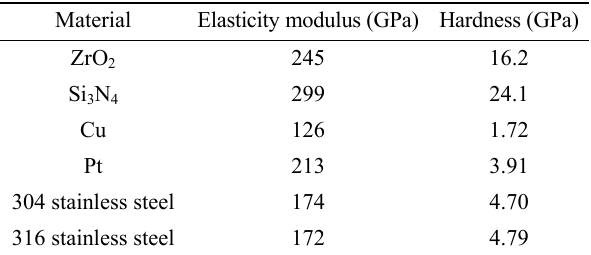
Table 1 Elasticity modulus and hardness of materials used in this work.